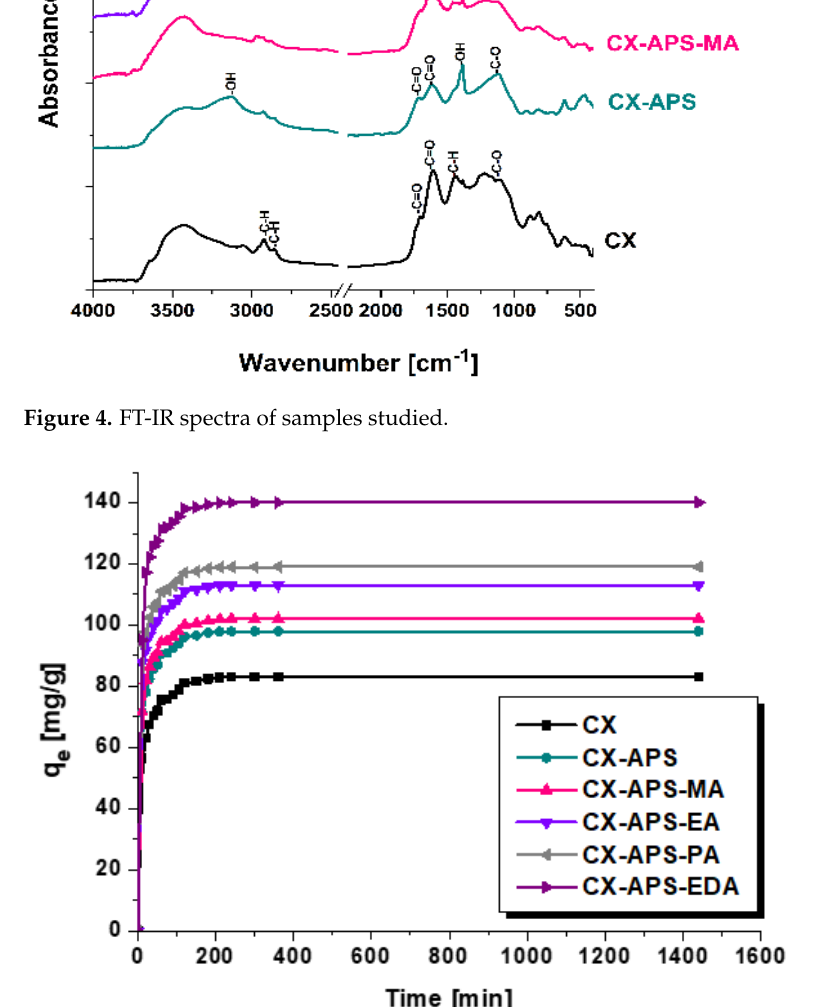
Table 3. Acid–base properties of carbon xerogels.